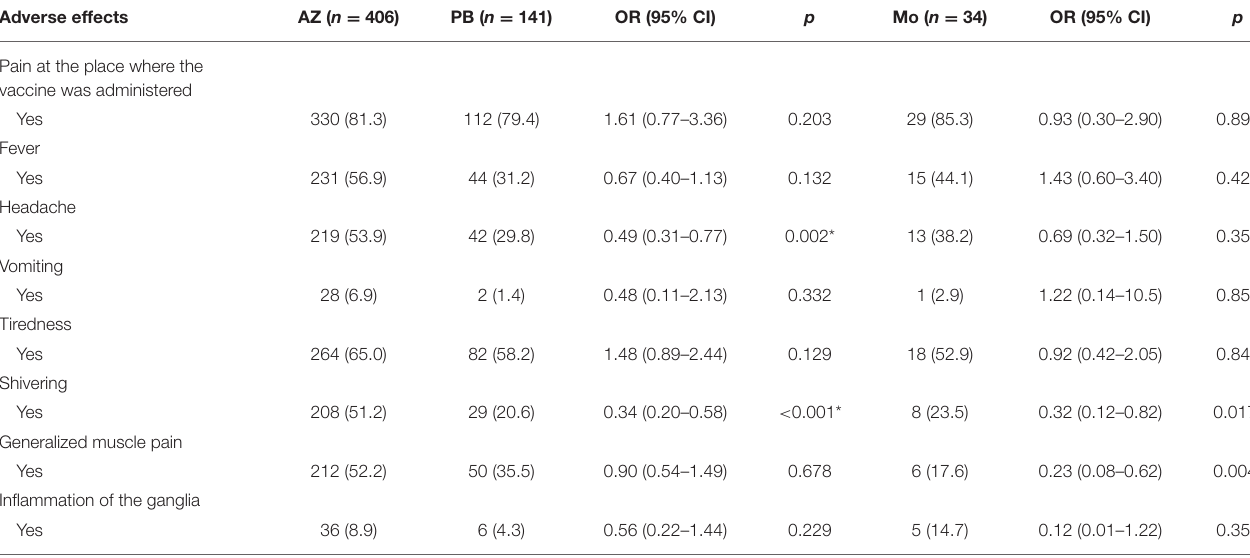
TABLE 4 | Multivariate logistic regression analyses showing adverse effects associated to the vaccine brand received by the physical therapists who participated in the study. Adverse